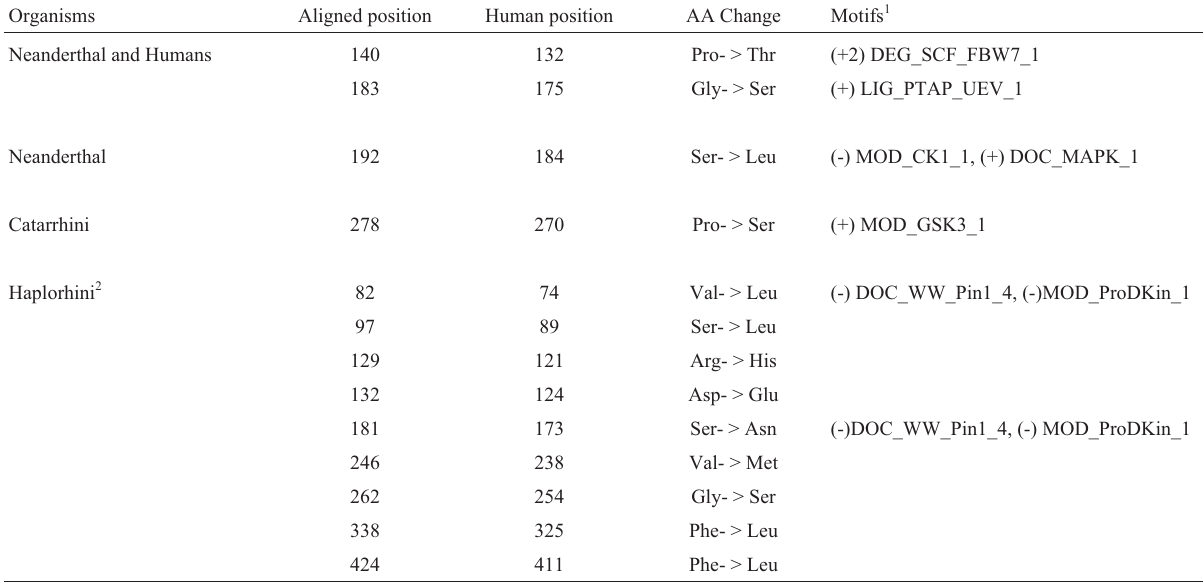
Table 4 - FOXP3-specific changes in primates. Organisms